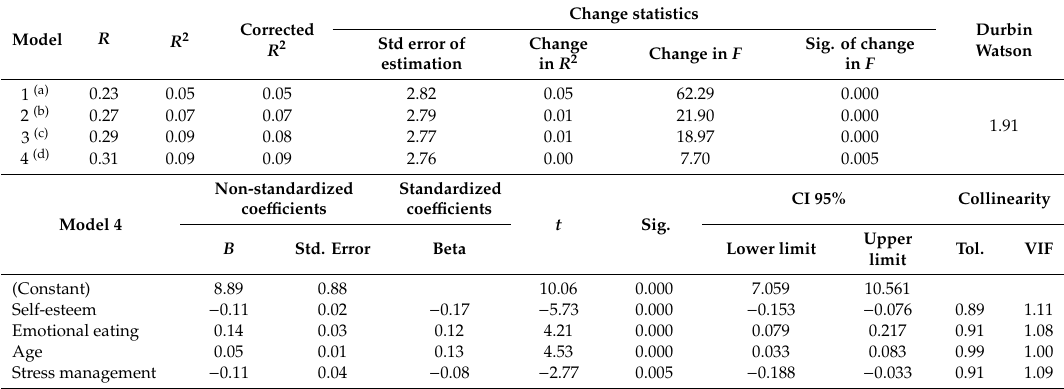
Table 2. Stepwise multiple linear regression model ( N =